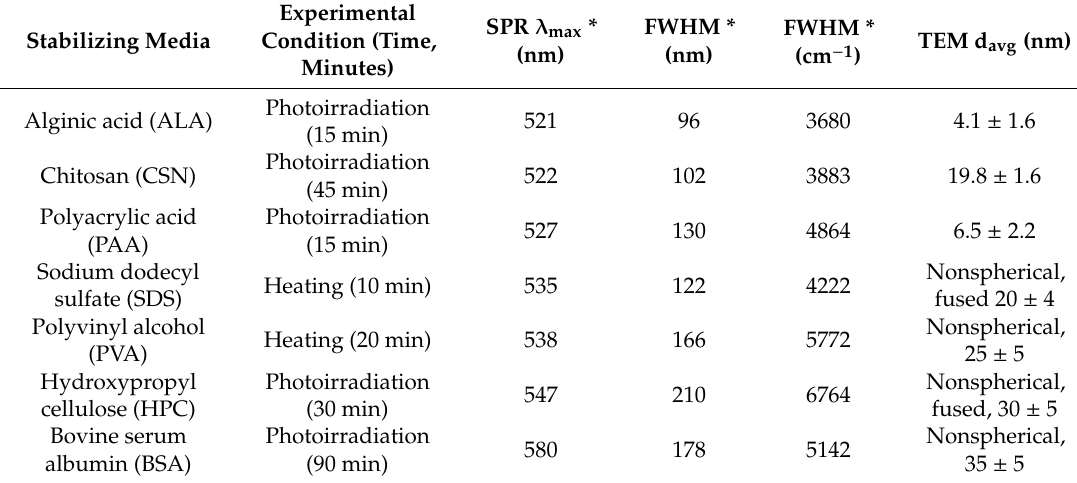
Table 2. Optical and morphological properties of AuNPs obtained under various experimental conditions within the wide range of stabilizing media (using Figure 7